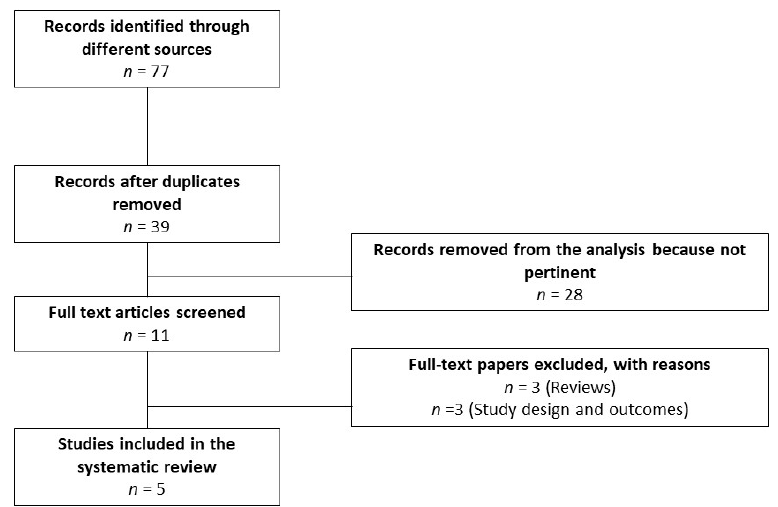
Figure 1. Flowchart of the studies included in systematic review.